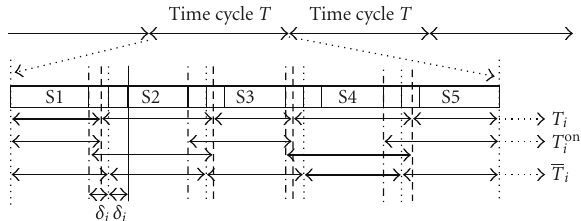
Figure 4: Example of timing diagram for the proposed time slicing and StatMux